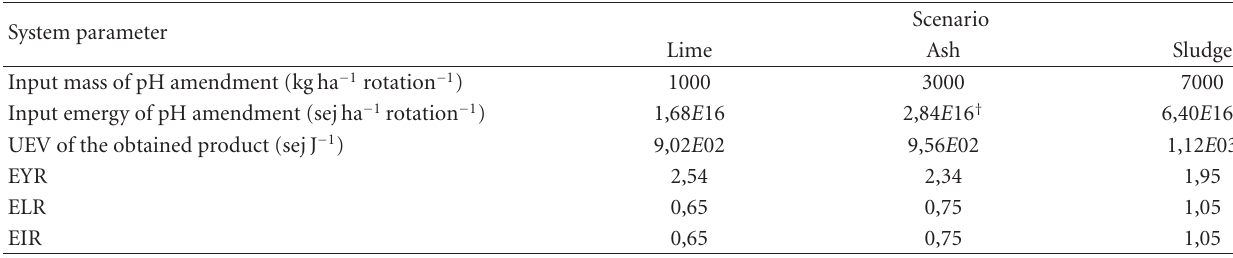
Table 4: Alternatives for soil pH